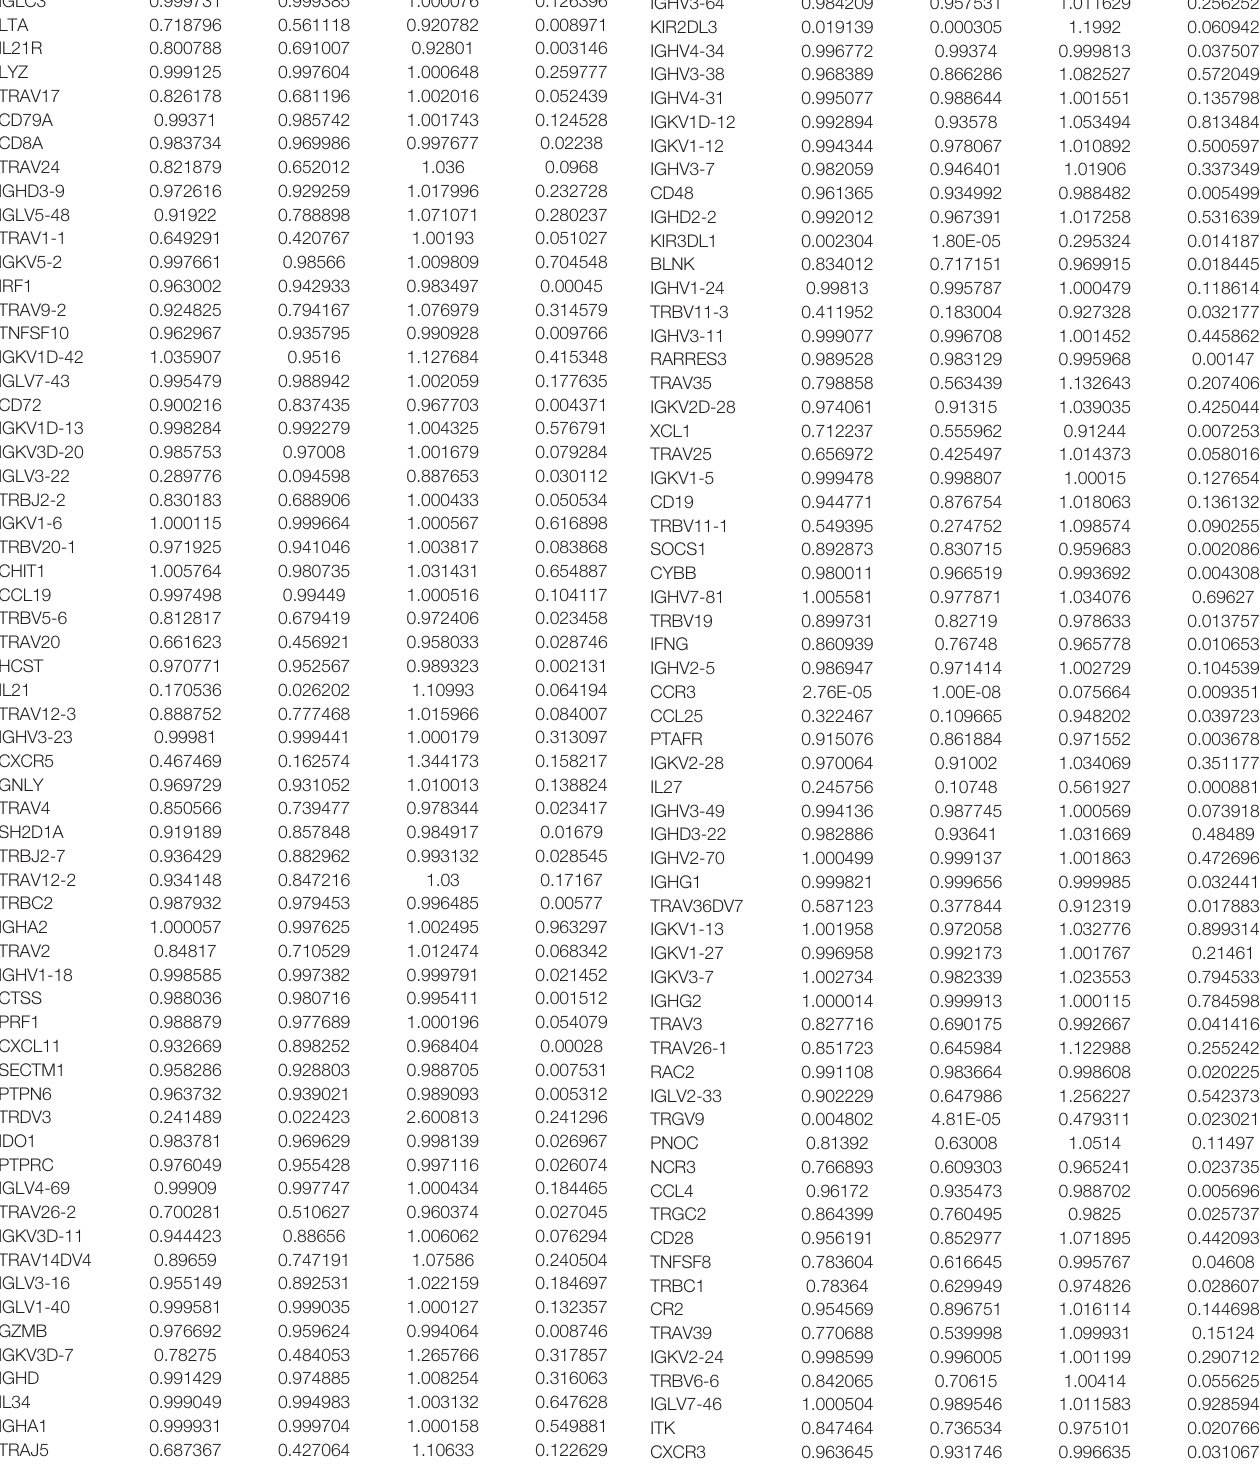
TABLE 1 | Univariate Cox proportional hazards regression